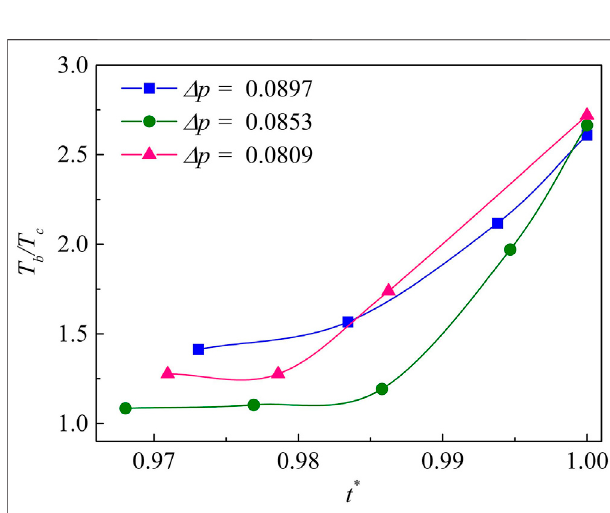
FIGURE 10 | Bubble temperature vs. time during the second collapse.